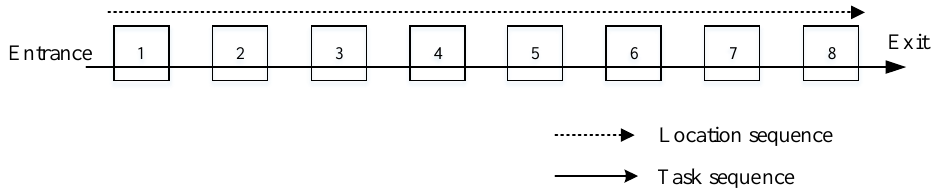
10 of 15 Figure 8. Layout of the U-shaped assembly cells. ( a ): number of tasks is odd ; ( b ): number of tasks is even. The walking time between any adjacent locations is one unit, and the minimal walk- ing time between both sides of a cell is two units. In this research, the walking time of one unit is the ratio of the average processing time, ranging between 0% and 20%. For exam- ple, in problem 1, proposed by Bowman [34], there are eight tasks, and the average pro- cessing time is 9.38. If one unit of walking time is 5% of the average processing time, the walking time between any adjacent locations is 0.469 (9.38 × 5%). To ensure that the walk- ing time between adjacent locations is one unit as in traditional straight production lines, when the number of tasks is even, the right-hand side of the cell is laid out as in Figure 8b. As all tasks are laid out in a grid system, the walking times between all pairs of loca- tions can be easily calculated using Pythagoras’ theorem.